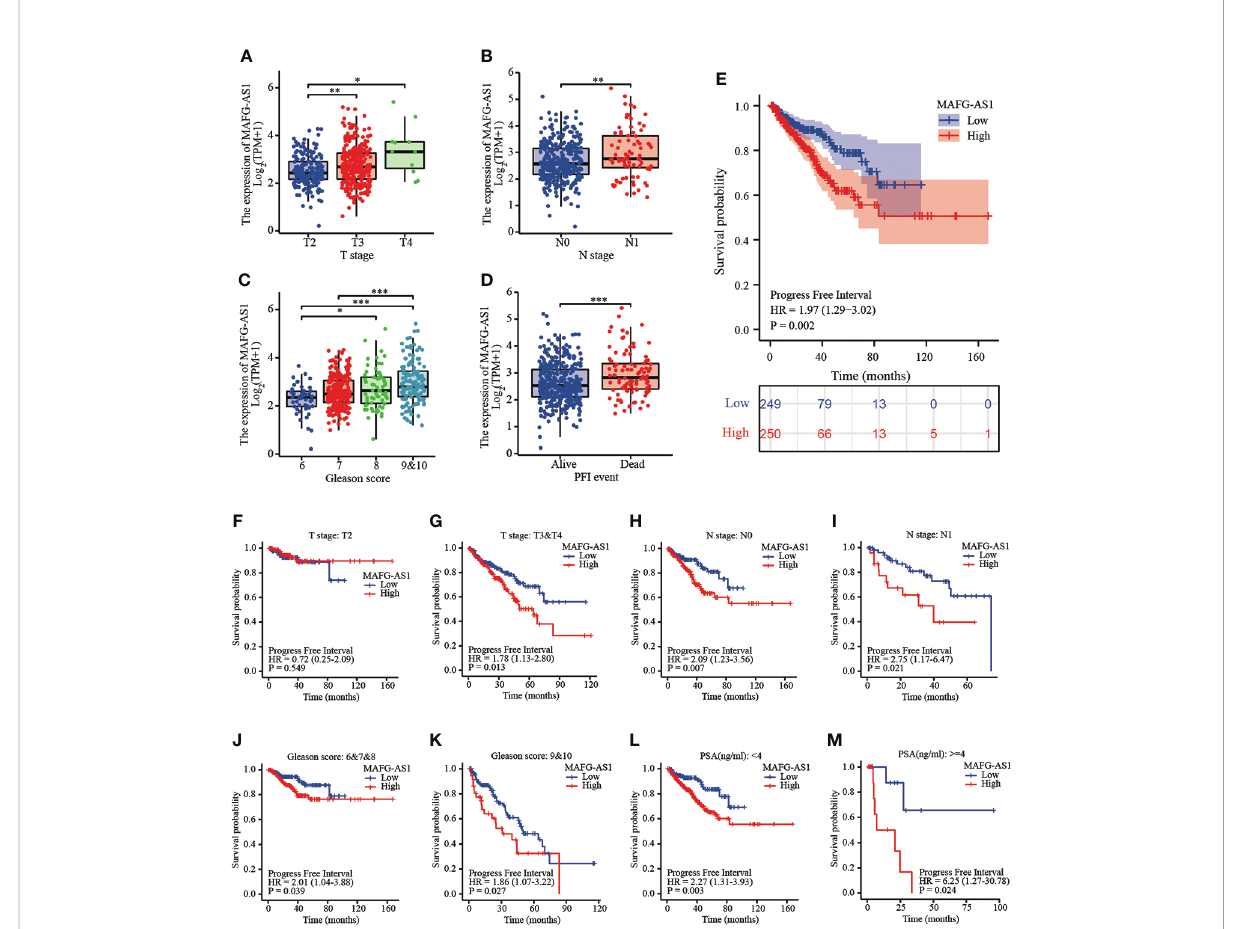
FIGURE 2 MAFG-AS1 was upregulated in advanced prostate cancer and indicated a poor prognosis. (A) MAFG-AS1 expression in prostate cancer with T3&T4 stage or T2 stage. (B) MAFG-AS1 expression in prostate cancer with N1 stage or N0 stage. (C) MAFG-AS1 expression in prostate cancer with Gleason score 6&7&8 or 9&10. (D) MAFG-AS1 expression in prostate cancer patients with different PFI. (E) Kaplan-Meier survival analysis revealed that prostate cancer patients with high MAFG-AS1 expression exhibited a shorter PFI. (F, G) Kaplan-Meier survival analysis of prostate cancer with different MAFG-AS1 level with T2 or T3&T4 stage. (H, I) Kaplan-Meier survival analysis of prostate cancer with different MAFG-AS1 level with N0 or N1 stage. (J, K) Kaplan-Meier survival analysis of prostate cancer with different MAFG-AS1 level with Gleason score 6&7&8 or